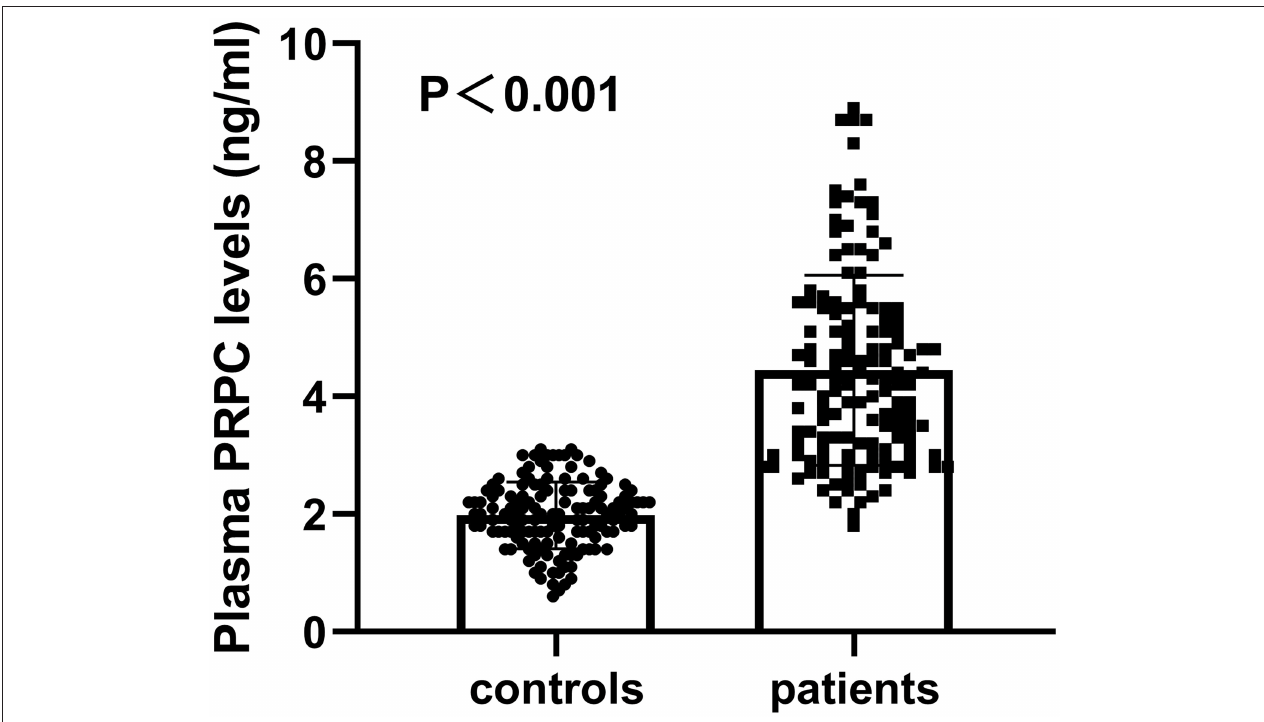
FIGURE 2 | Differences in plasma cellular prion protein levels between healthy controls and patients with cerebral hemorrhage. Using the Mann–Whitney U -test, plasma cellular prion protein levels significantly higher in patients with ICH ( n = 138) than in healthy controls ( n = 138) ( P < 0.001). Abbreviation: PRPC, cellular prion